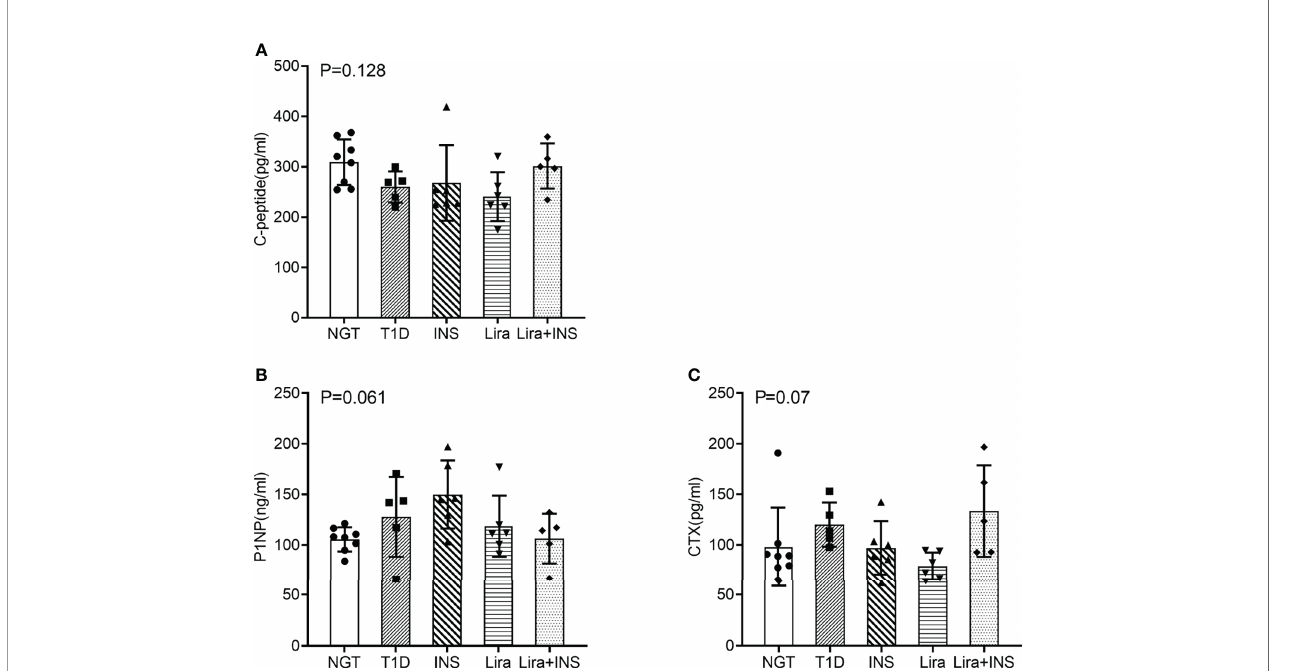
FIGURE 6 | Serum bone turnover markers and C-peptide. (A) C-peptide; (B) procollagen type 1 N-terminal propeptide (P1NP); (C) C-terminal cross-linking telopeptide of type 1 collagen (CTX). NGT, normal glucose tolerance group; T1D, type 1 diabetes group; INS, insulin treatment group; Lira, liraglutide treatment group; INS+Lira, insulin + liraglutide treatment group; ANOVA was used for comparison between groups, and p < 0.05 was de fi ned as statistically signi fi cant. All data are expressed as mean ±